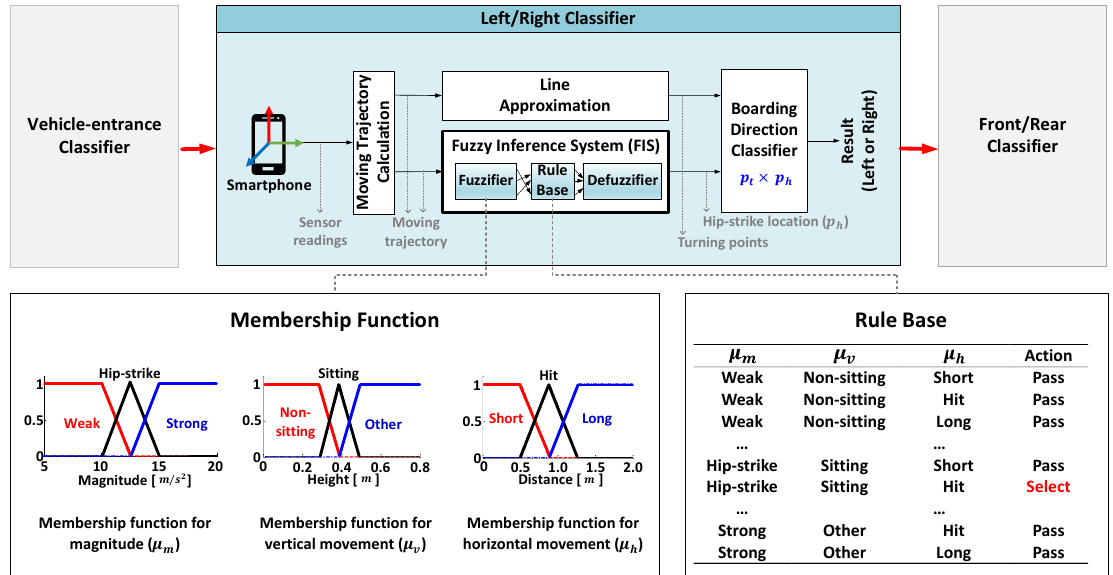
Figure 1. The proposed system consisting of three building blocks for: (1) detecting a vehicle-entrance event; (2) determining the side (left or right) of vehicle-boarding; and (3) differentiating the seated row (front or rear), where the left/right classification employs a fuzzy inference system (FIS) to maximize the